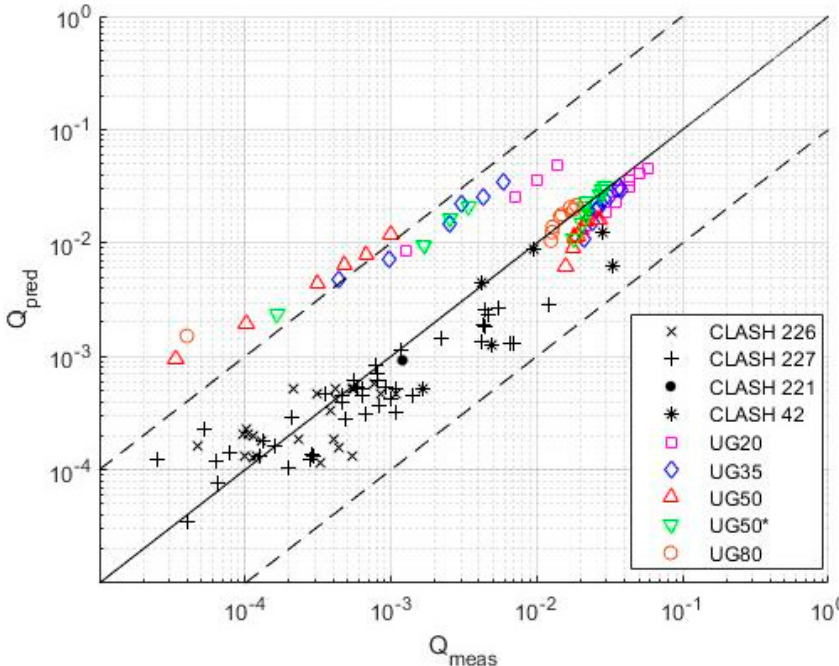
Figure 8. Measured versus predicted nondimensional overtopping discharge using the Goda [9] formula (solid line: prediction equal to measured rate; dashed lines: prediction equal to 10 times higher and lower than the measured rate).